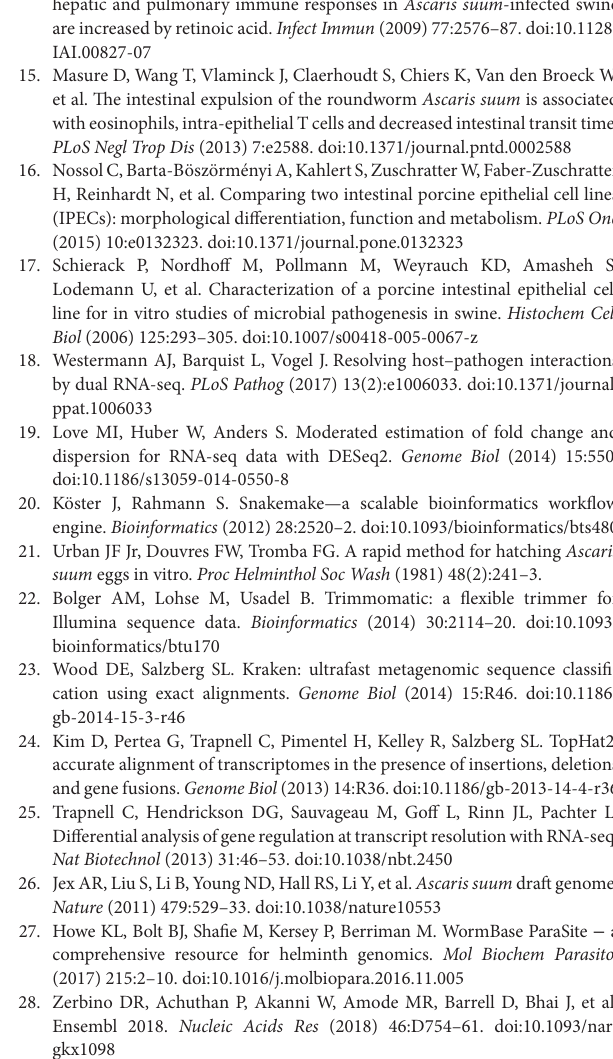
TaBle s1 | Differentially expressed genes pig and worm total. TaBle s2 | Co-expression analysis: GEN nodes, GEN edges, GEN cluster. TaBle s3 | Gene ontology (GO) term declination for GO filters. TaBle s4 | Genome of Ascaris suum L3 and